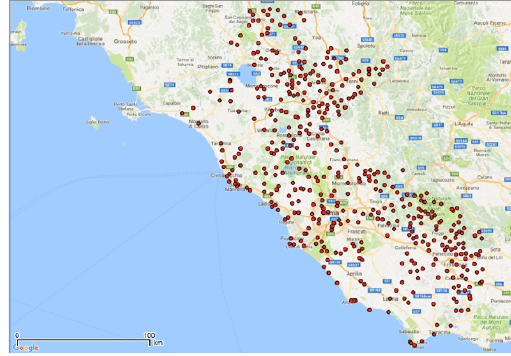
Figure 1. Point distribution in "Città metropolitana di Roma